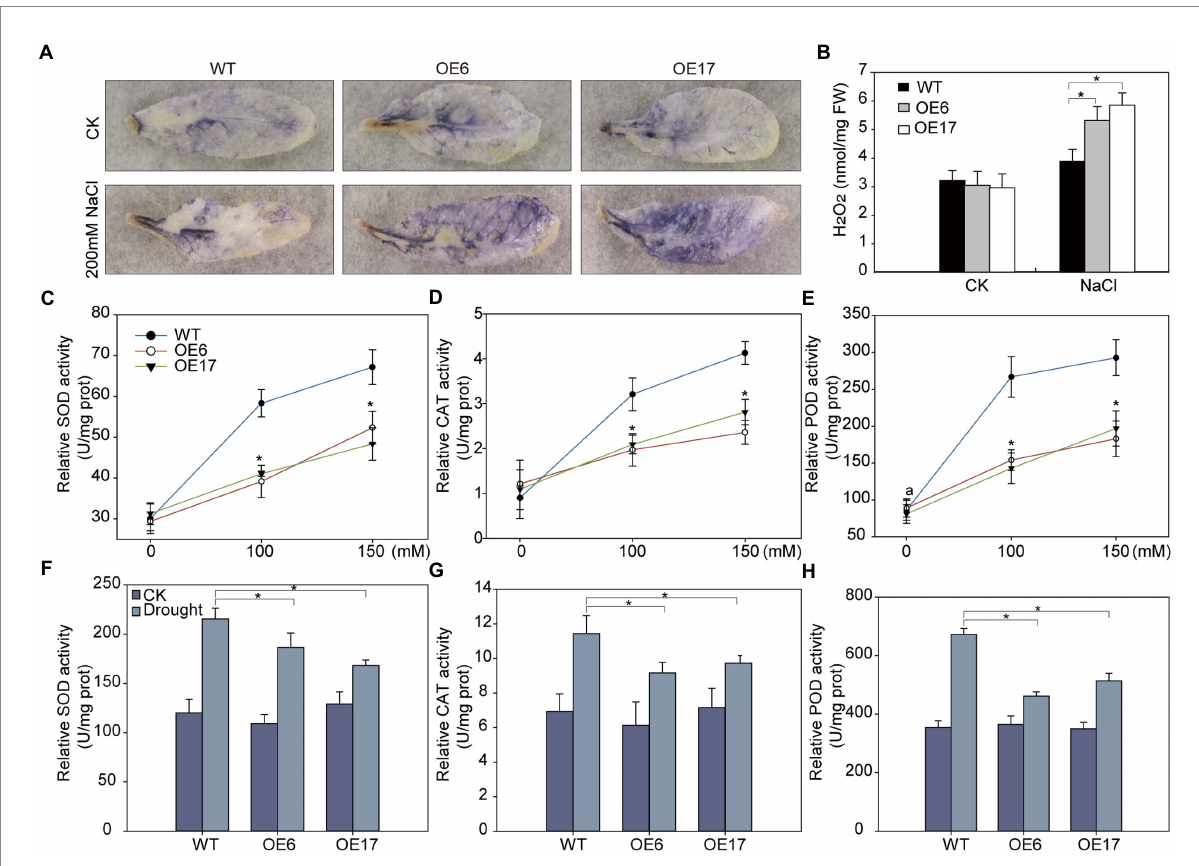
FIGURE 5 NtNAC028 promotes reactive oxygen species (ROS) accumulation under NaCl treatments. (A) NBT staining. The middle leaves of 4-week-old NtNAC028 overexpression lines and WT with or without NaCl treatments were used for NBT staining. (B) Measurement of accumulation of H 2 O 2 in detached leaves of plants with different genotypes. (C–H) POD, SOD, and CAT activities of NtNAC028 overexpression lines and WT after salt and drought stress treatments. The bars are standard deviations (SD) of three biological replicates. Asterisks indicate statistically significant difference from WT (* p <